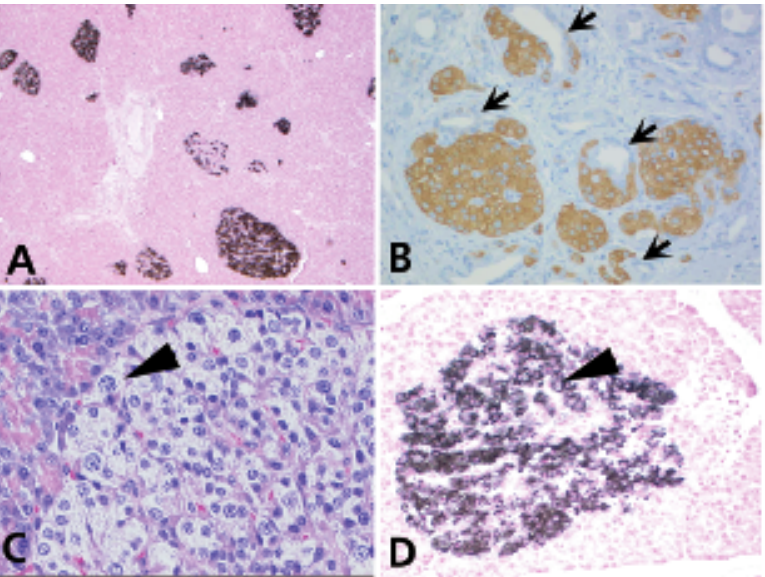
Pathology findings A. Insulin